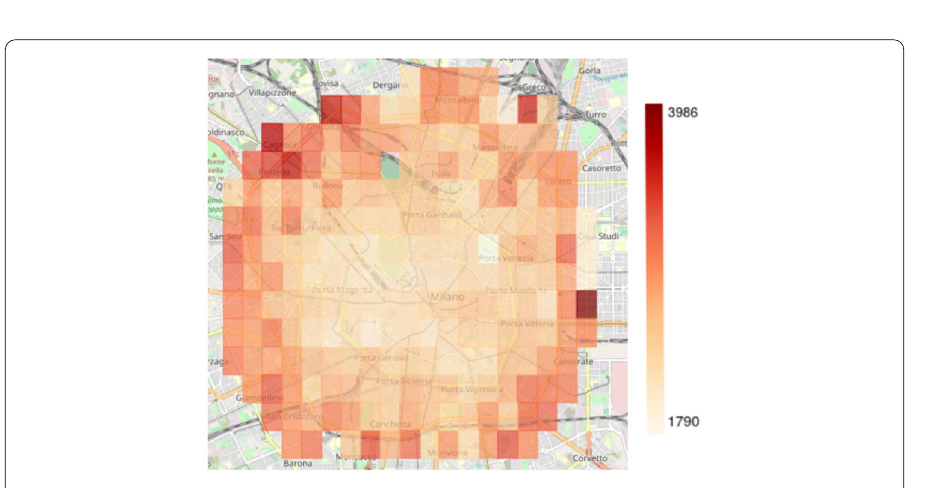
Figure 2 Travel